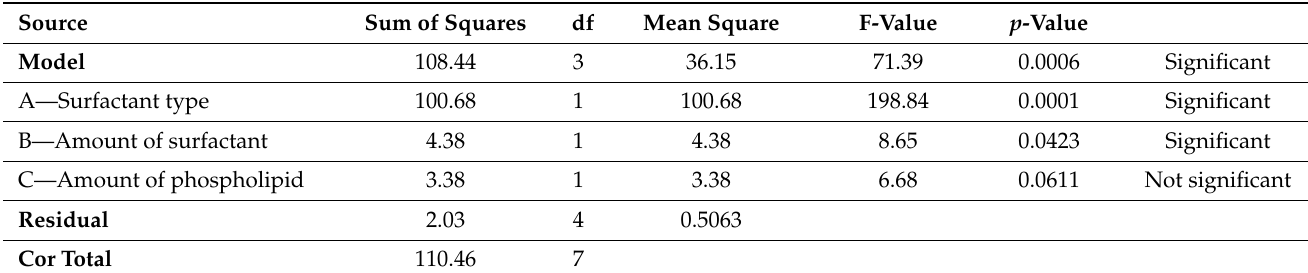
Table 4. ANOVA analysis for the effect of formulation factors in the EE%